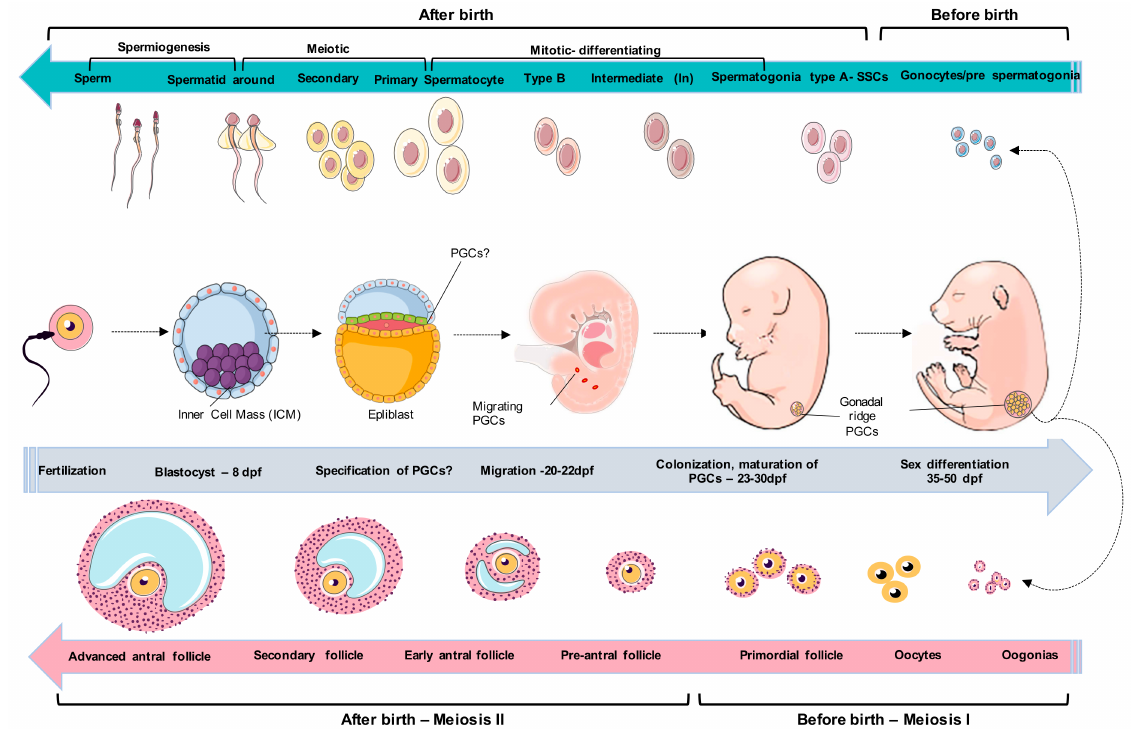
Figure 1. Schematic model of canine germ-cell development. After implantation of blastocysts, some canine germ cells will emerge; however, they could be around the amnion or the epiblast. Canine primordial germ cells (PGCs) undergo migration for 20–22 days post-fertilization (dpf) through developing hindgut and mesentery and colonize the genital ridges during 23–25 dpf. The canine PGCs enter the cell maturation process around 27–30 dpf. The period around 35–40 dpf is marked by the initiation of sexual differentiation, during which the cells can be morphologically distinguished as males or females. The male gonads undergo major morphological changes, medullary cords are differentiated into seminiferous cords. The female gonadal ridge was divided into the medulla (inside the gonad) and cortex (outside of the gonad). Around 45–55 dpf, gonads exhibit simple testes precursors called fetal testes, and female PGCs undergo oogonia, respectively. The testicular cords vary in size, and individual pre-spermatogonial cells are present inside the testicular cords. During this period of sex differentiation, few studies are related. After this period, the cells initiate spermatogenesis and oogenesis, which are ovulated for fertilization. Figure adapted from Yamashiro et al. (2018) [27]. Figure created in the Mind the Graph